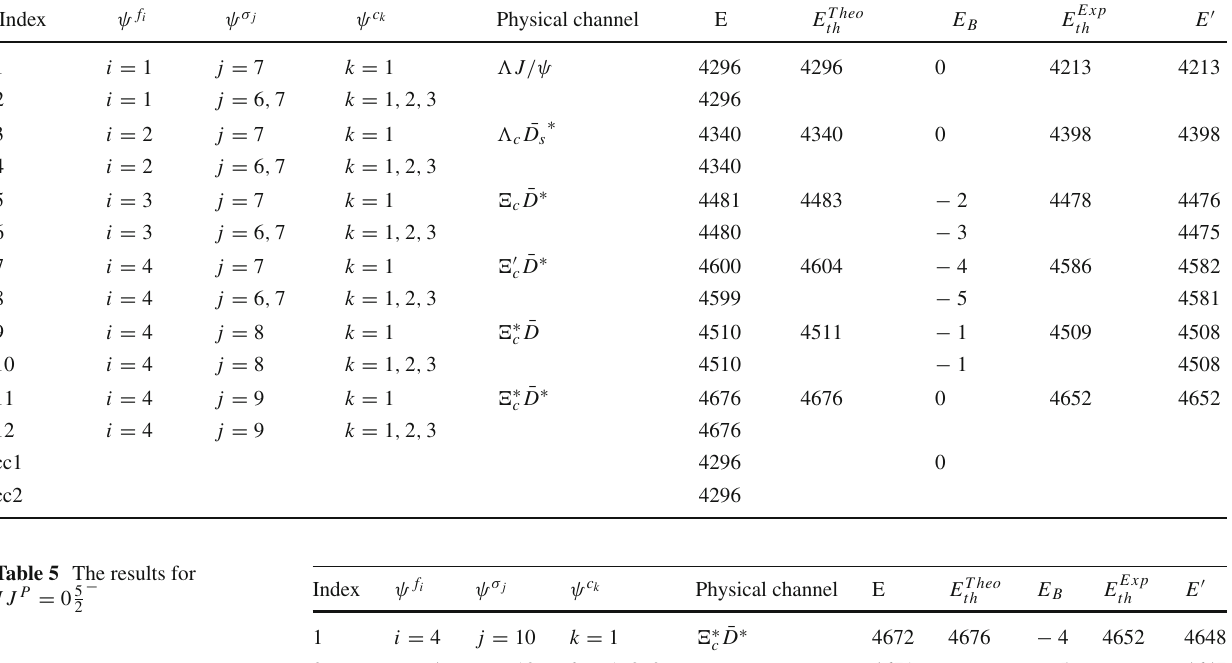
− . cc1: mixing of color singlet-singlet channels, cc2: mixing of all channels (unit: MeV) 2